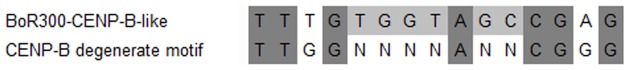
CENP-B like motif.Comparison of the CENP-B like motif (237–252 bp) found in BoR300 with the degenerate motif considered to bind the CENP-B protein.